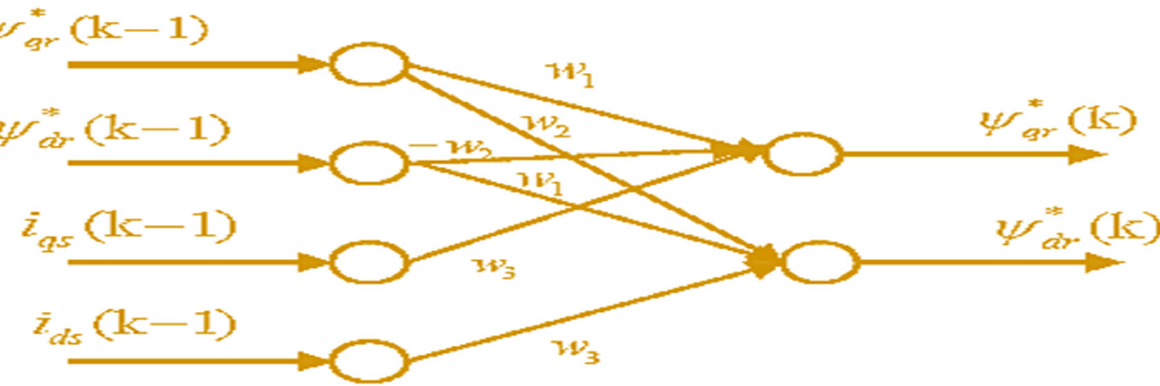
Figure 4. Proposed ANN-based model reference adaptive system technique.